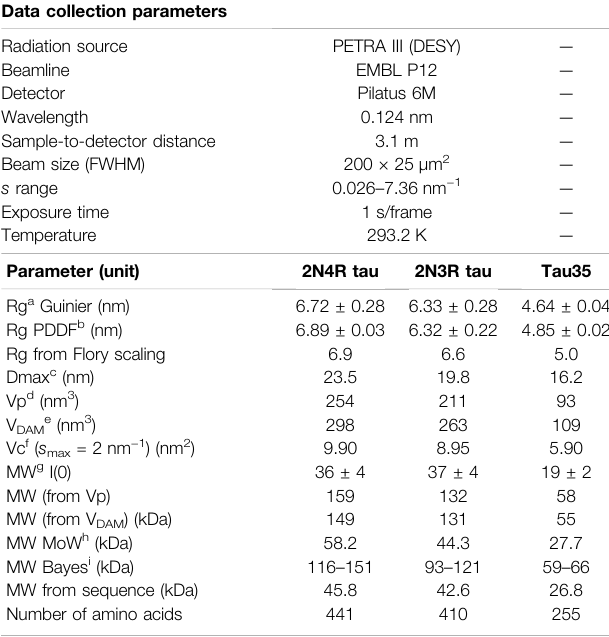
TABLE 1 | SAXS data collection and analysis.